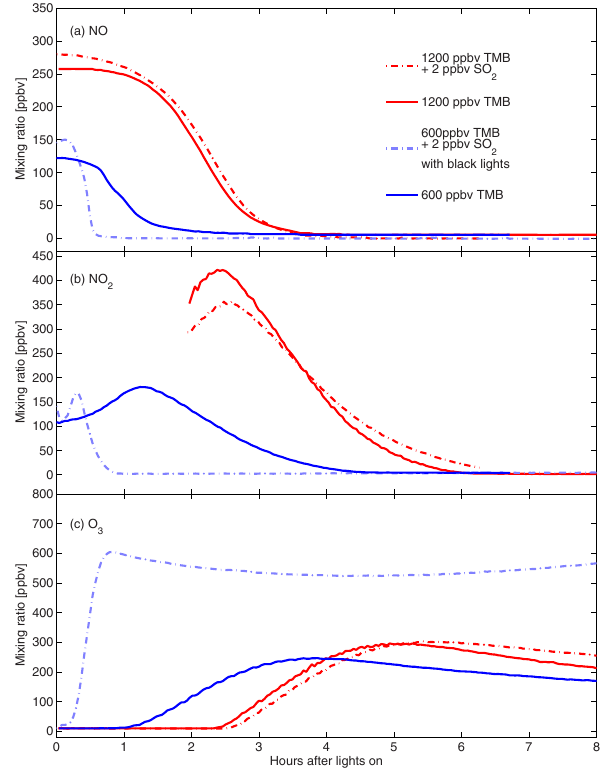
Figure 3. Nitrogen oxide (NO, a ), nitrogen dioxide (NO 2 , b ) and ozone (O 3 , c ) mixing ratios for the different experiments. High con- centration experiments: red; low concentration experiments: blue; without SO 2 : solid lines; with SO 2 : dashed lines. NO 2 data are missing at the beginning of the high concentration experiments, due to an instrumental limitation.